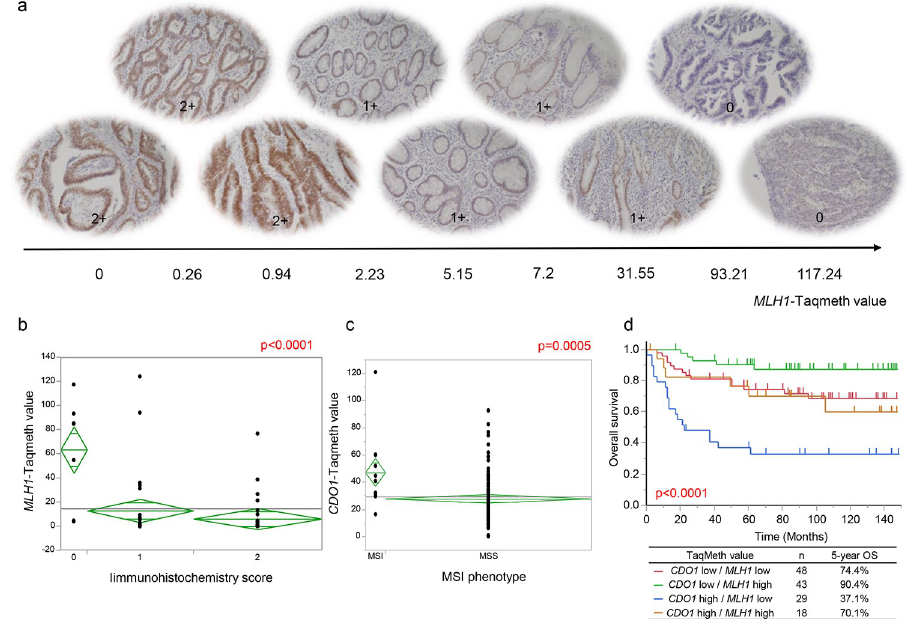
Fig 4. (a) MLH1 promoter DNA methylation affecting protein expression in tumor tissue. Expression of MLH1 proteins in three groups (0, 1 +, 2 +) with different MLH1 TaqMeth value. (b) MLH1 TaqMeth value distribution in the gastric cancer tissues according to three groups of immunochemistry score (0, 1+, 2+). (c) CDO1 TaqMeth value distribution in the gastric cancer tissues according to microsatellite instability (MSI) phenotype (MSI or Microsatellite stable; MSS). (d) Kaplan-Meier survival curves for overall survival comparing gastric cancer patients with combination of MLH1 and CDO1 TaqMeth value ( P <